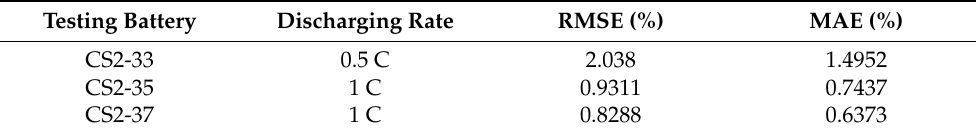
Figure 10. SOH estimation results based on the batteries CS2-35 and CS2-37. ( a ) SOH estimation for CS2-35; ( b ) SOH estimation for CS2-37; ( c ) SOH estimation errors of each cycle for battery CS2-35; ( d ) SOH estimation errors of each cycle for battery CS2-37. Table 3. The RMSE and MAE results for the batteries under different charging rates. Testing Battery Discharging Rate RMSE